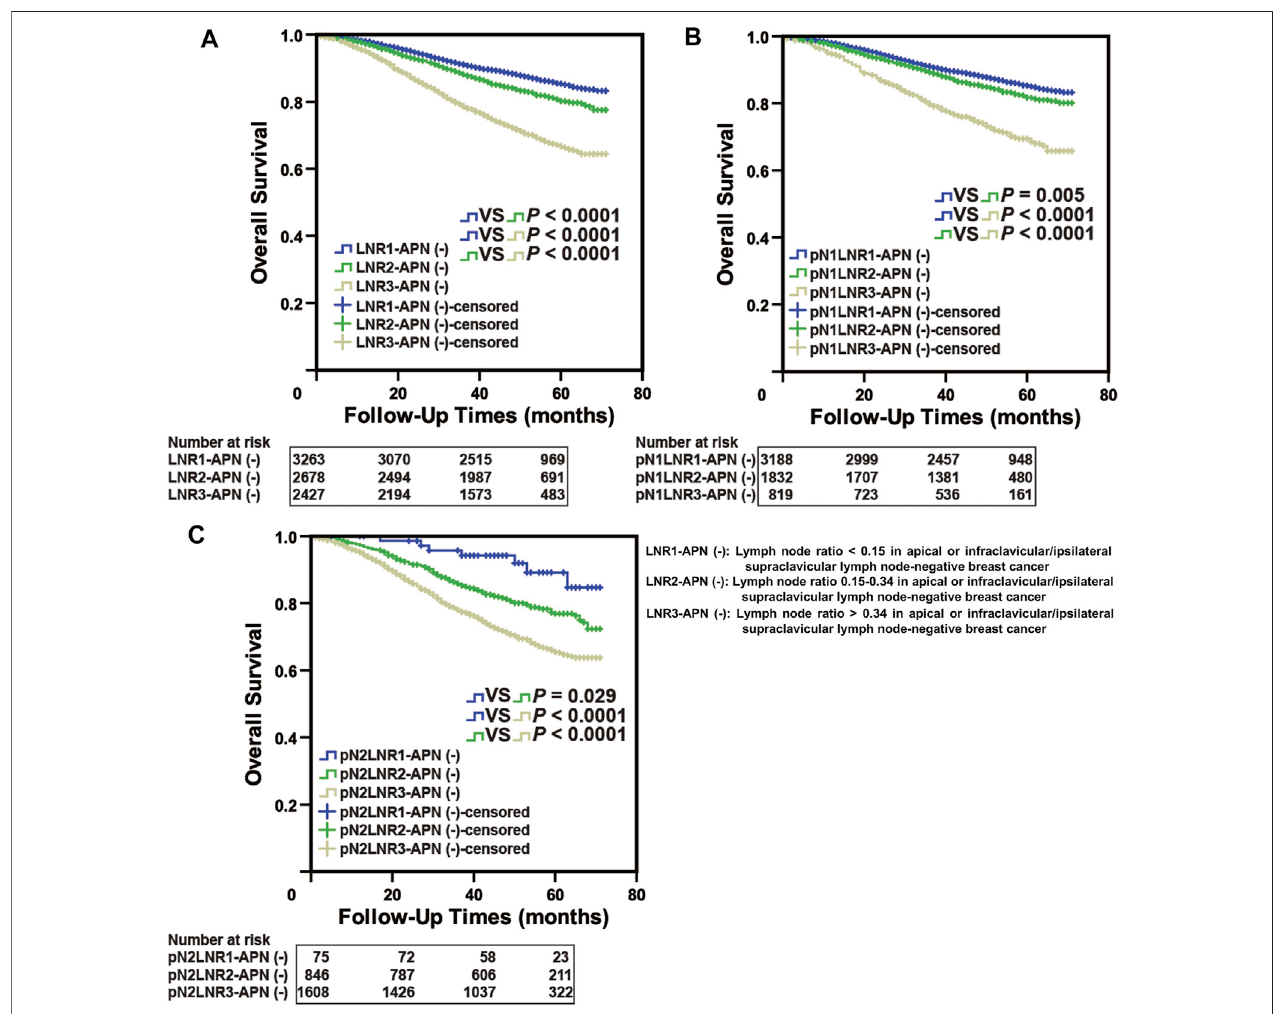
FIGURE 5 | LNR-APN( − ) could accurately predict the prognosis of pN1 and pN2 stage breast cancer patients in the SEER database. Kaplan – Meier analysis of (A) LNR-APN( − ) breast cancer patients ( n = 8,380), (B) pN1-LNR-APN( − ) breast cancer patients ( n = 5,846), and (C) pN2-LNR-APN( − ) breast cancer patients ( n = 2,534).